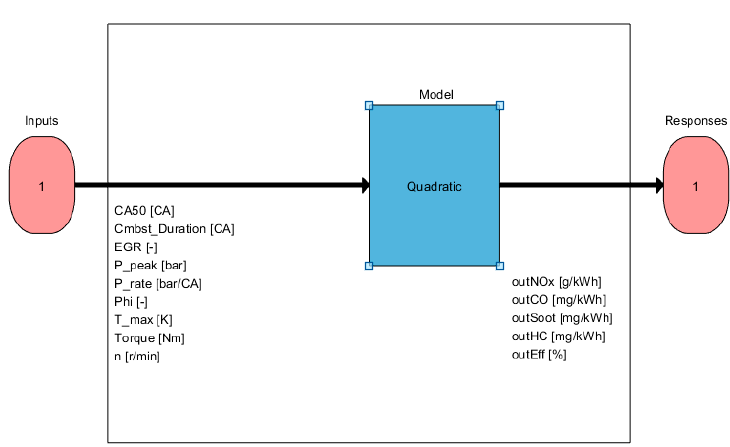
Figure 6. Model setup in Mode-Based Calibration tools.